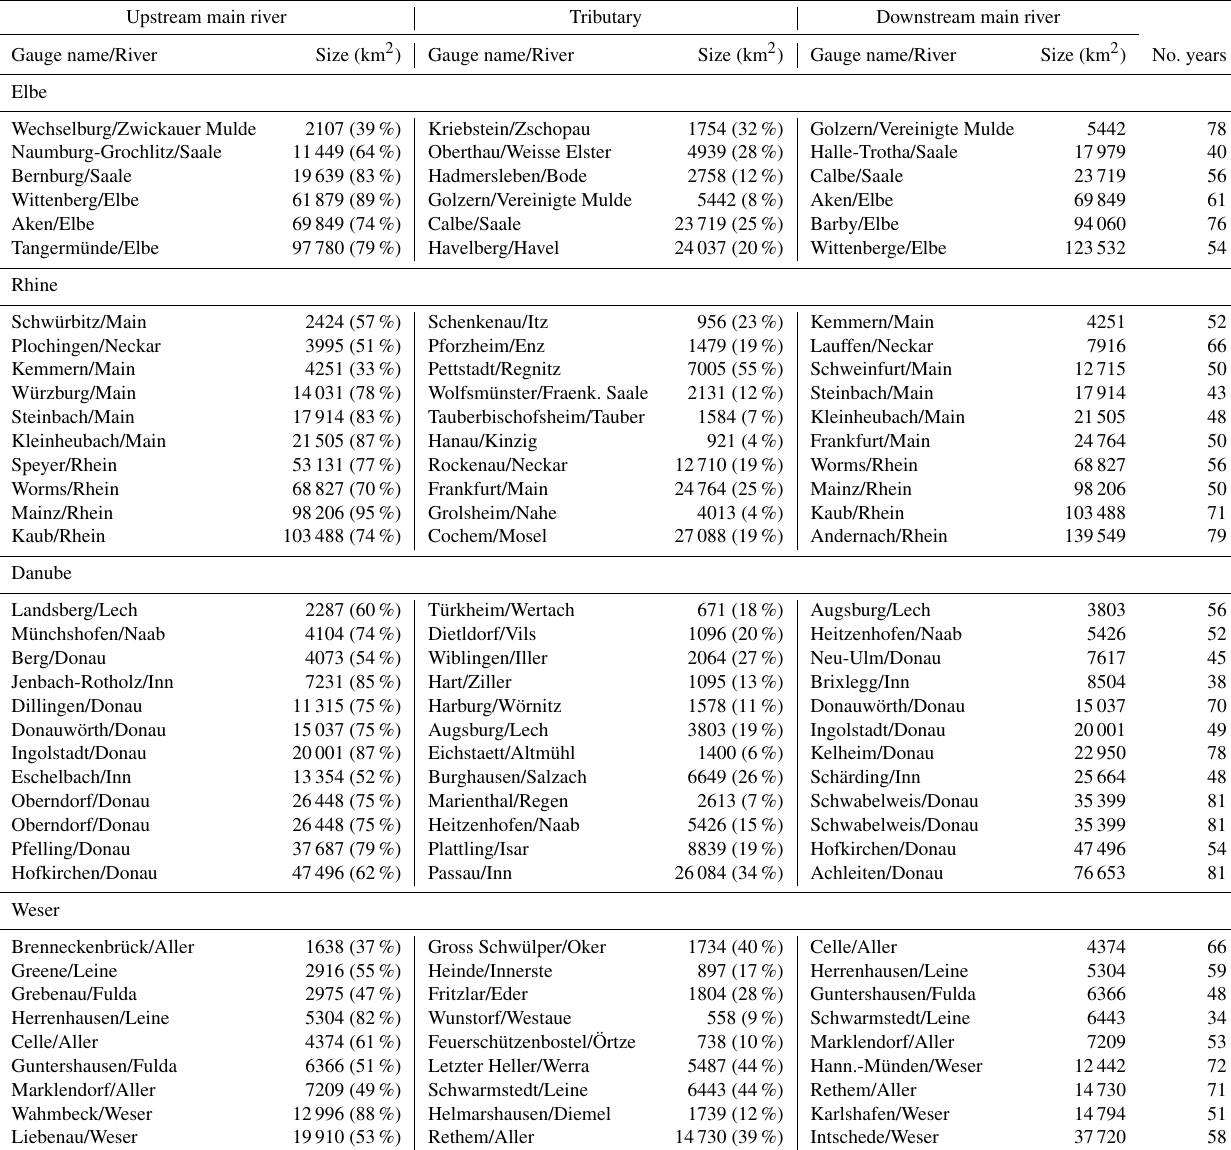
Table 1. Triple points of the four major river basins ordered by the catchment size of the downstream gauge. The percentages in parentheses denote the share of the tributary and of the main river upstream gauge in relation to the catchment size of the downstream gauge. The last column shows the number of years for each of the triple